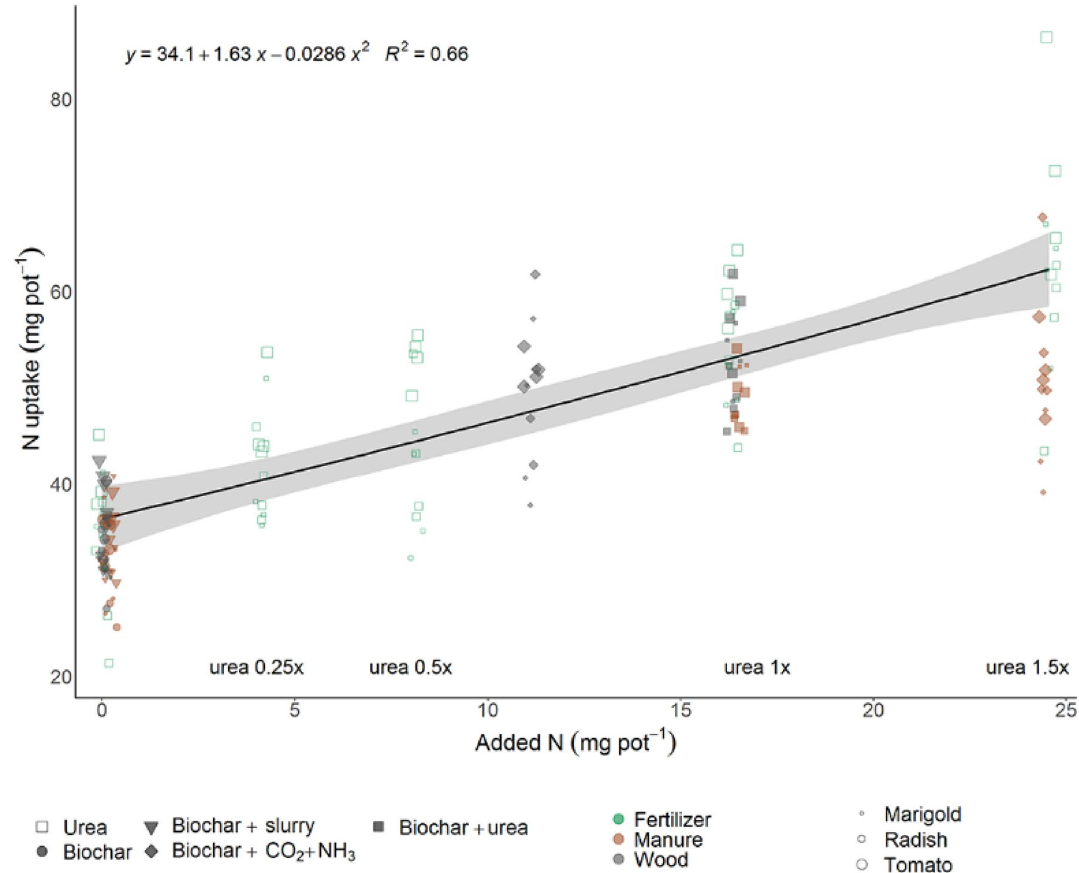
Figure 3. Nitrogen uptake of shoots and roots of plants grown with amendments varying in initial N content (points). “Added N” refers to the KCl-extractable N of all amendments, with the assumption that all urea-N is KCl-extractable. A linear regression was conducted for urea-based amendments (urea, biochar + urea). The 95% confidence interval is shown by the gray shaded line, and the R 2 value for the quadratic equation is presented (n =